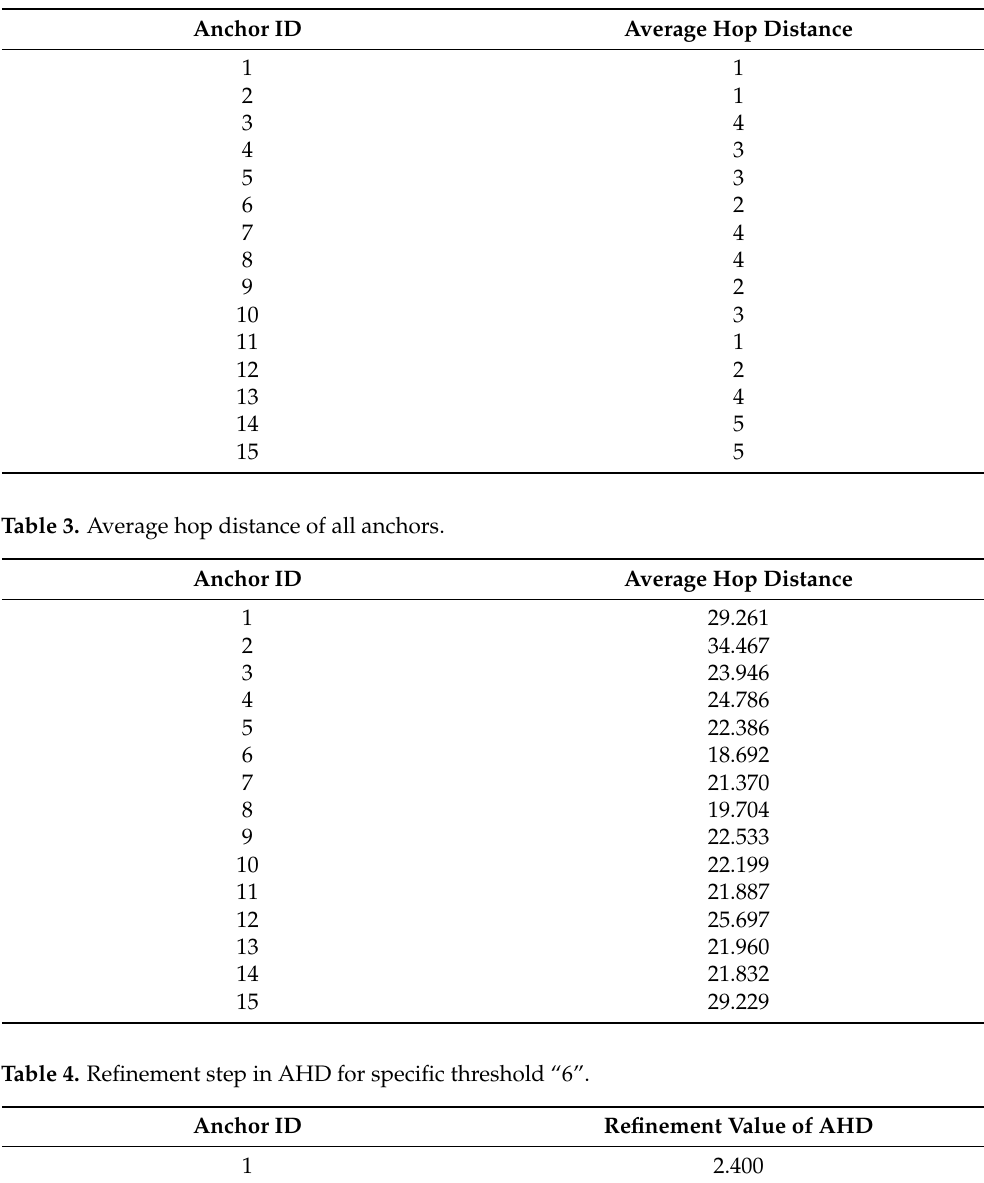
Table 2. Minimum hop of node “N” from every anchor.